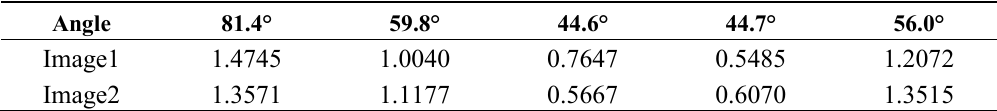
Table 6. Weight of each angle image for the RESW method in the simulation image data experiment.